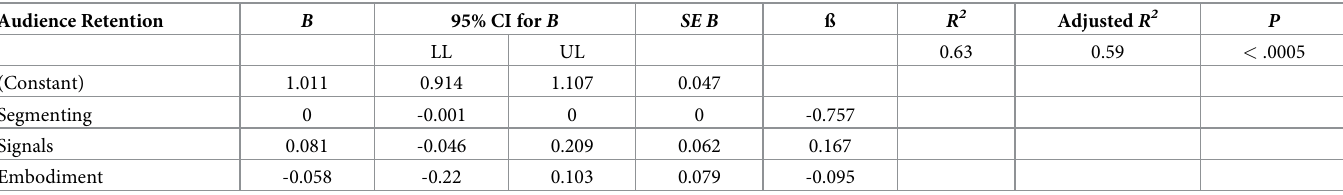
Table 4. Multiple regression results for audience